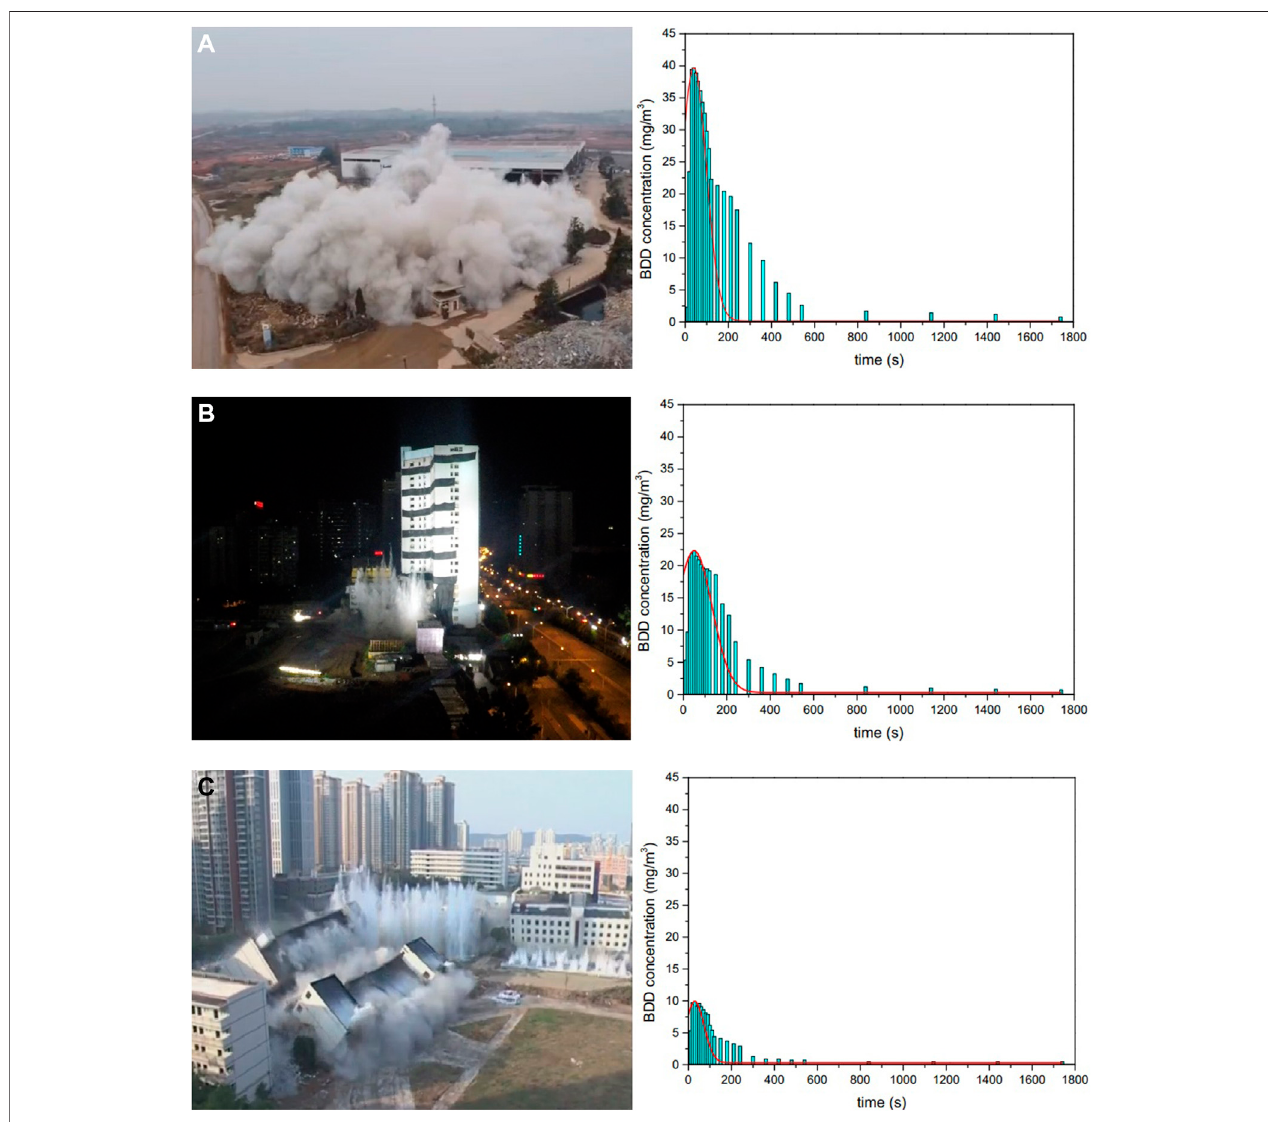
FIGURE13| BDDconcentrationanddiffusioncharacteristicinblastingprojects, (A) withoutBDDsuppressionprocess, (B) suppressionwithmunicipalwatermist, and (C) suppression with surfactant solution mist.